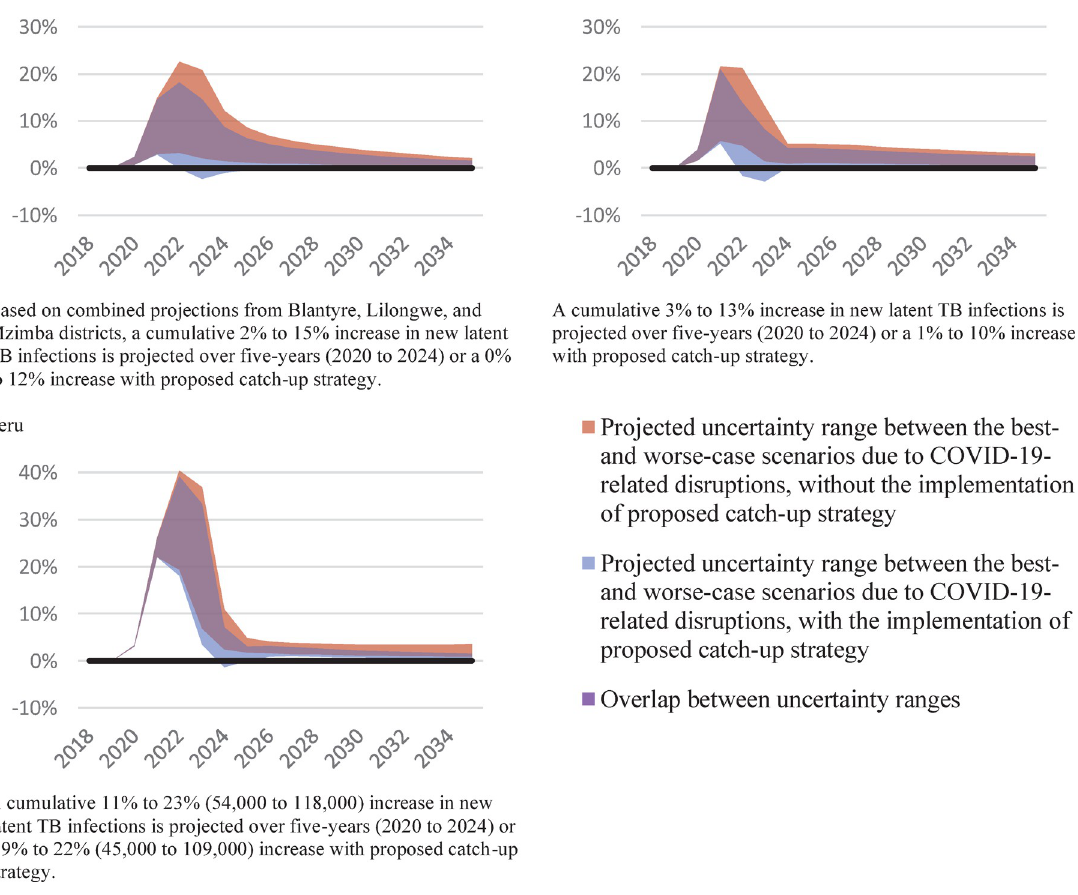
Fig 2. Impact of COVID-19-related disruptions to TB services on new latent TB infections, relative difference to the status quo counterfactual, 2018–2035.